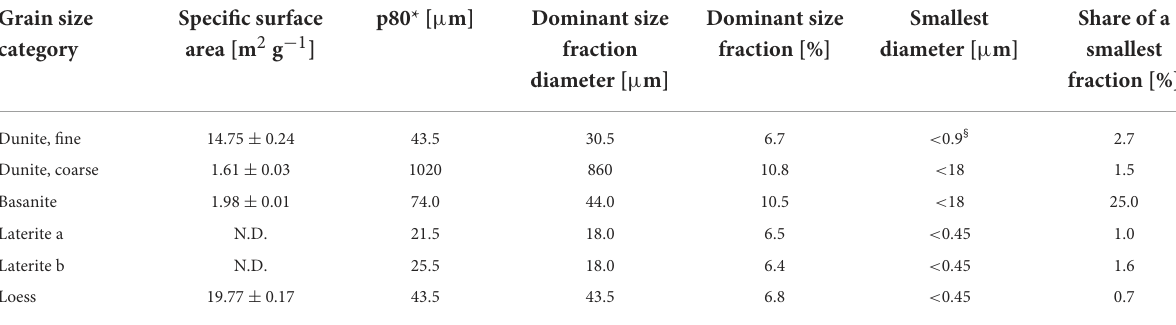
TABLE 2 Specific surface areas of the source material, derived by BET analyses, as well as grain size distribution characteristics.